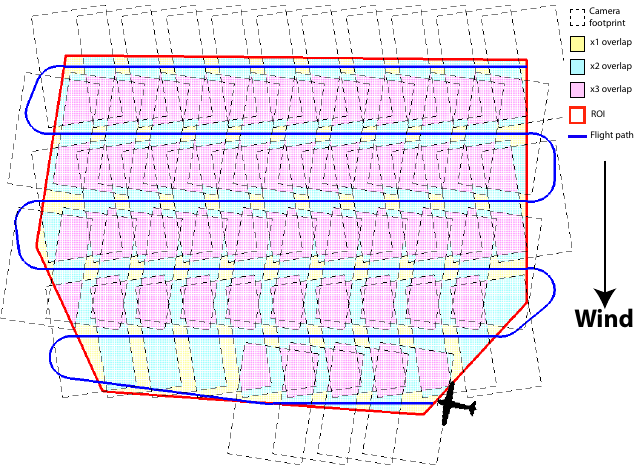
Figure 1. Example convex survey with a sidelap 40% and an overlap 40%, showing the Boustrophedon Coverage Path Planning (CPP), also showing the image